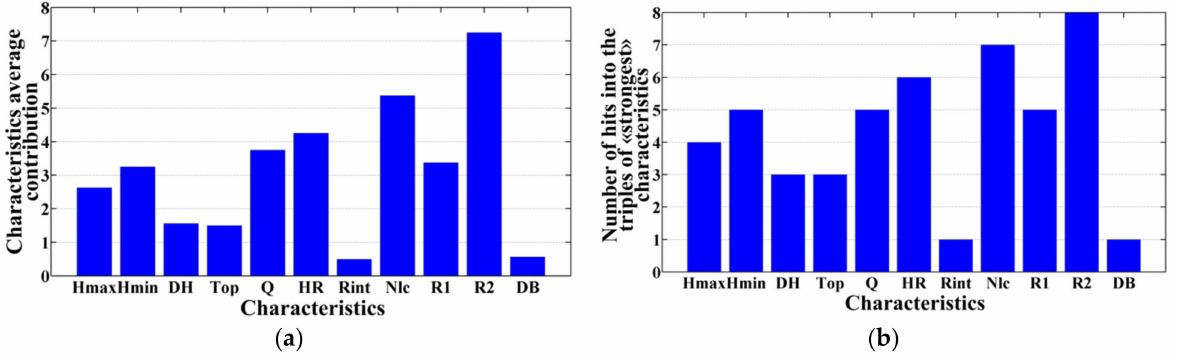
Figure 5. The contribution of characteristics to the recognition, using the “Barrier-3” algorithm, of a high seismicity set of objects in the Caucasus: ( a ) average contribution of characteristics; ( b ) the contribution of characteristics expressed through their attribution to the “strongest”